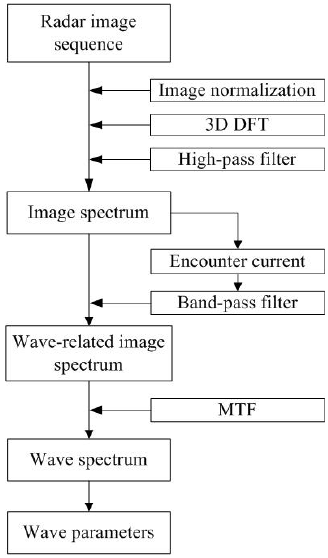
Figure 7. Basic steps of the traditional 3D discrete Fourier transform (3D-DFT)-based